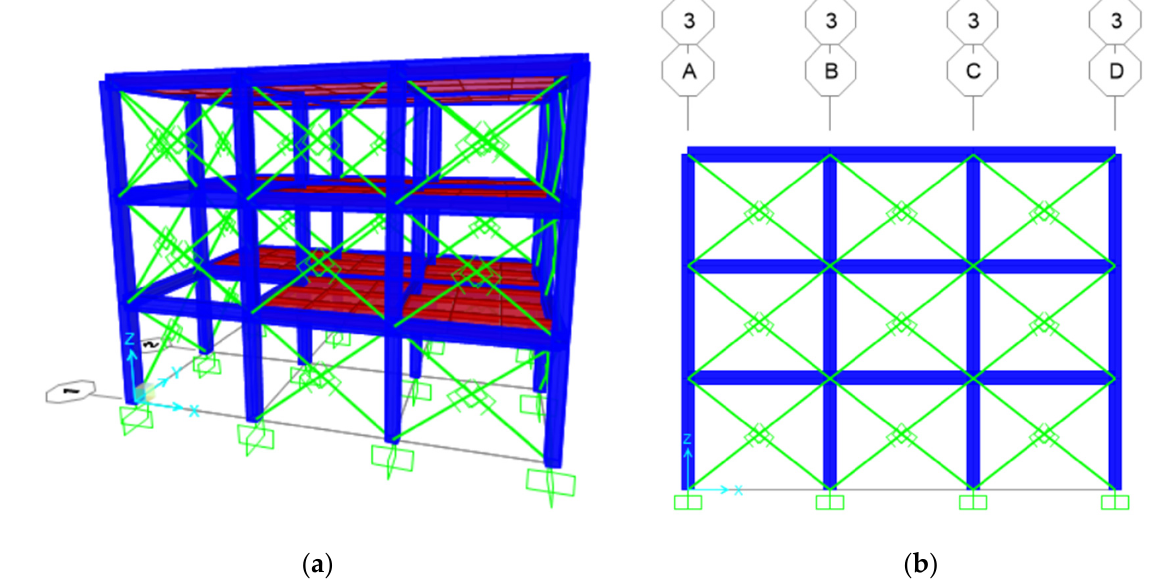
Figure 6. Finite element model of the building: ( a ) 3D model with infill; ( b ) 2D elevation of infill.